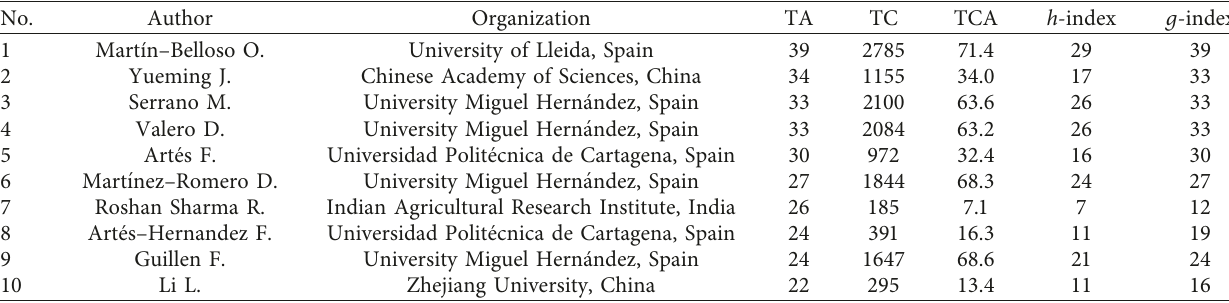
Table 6: The profile of the top 10